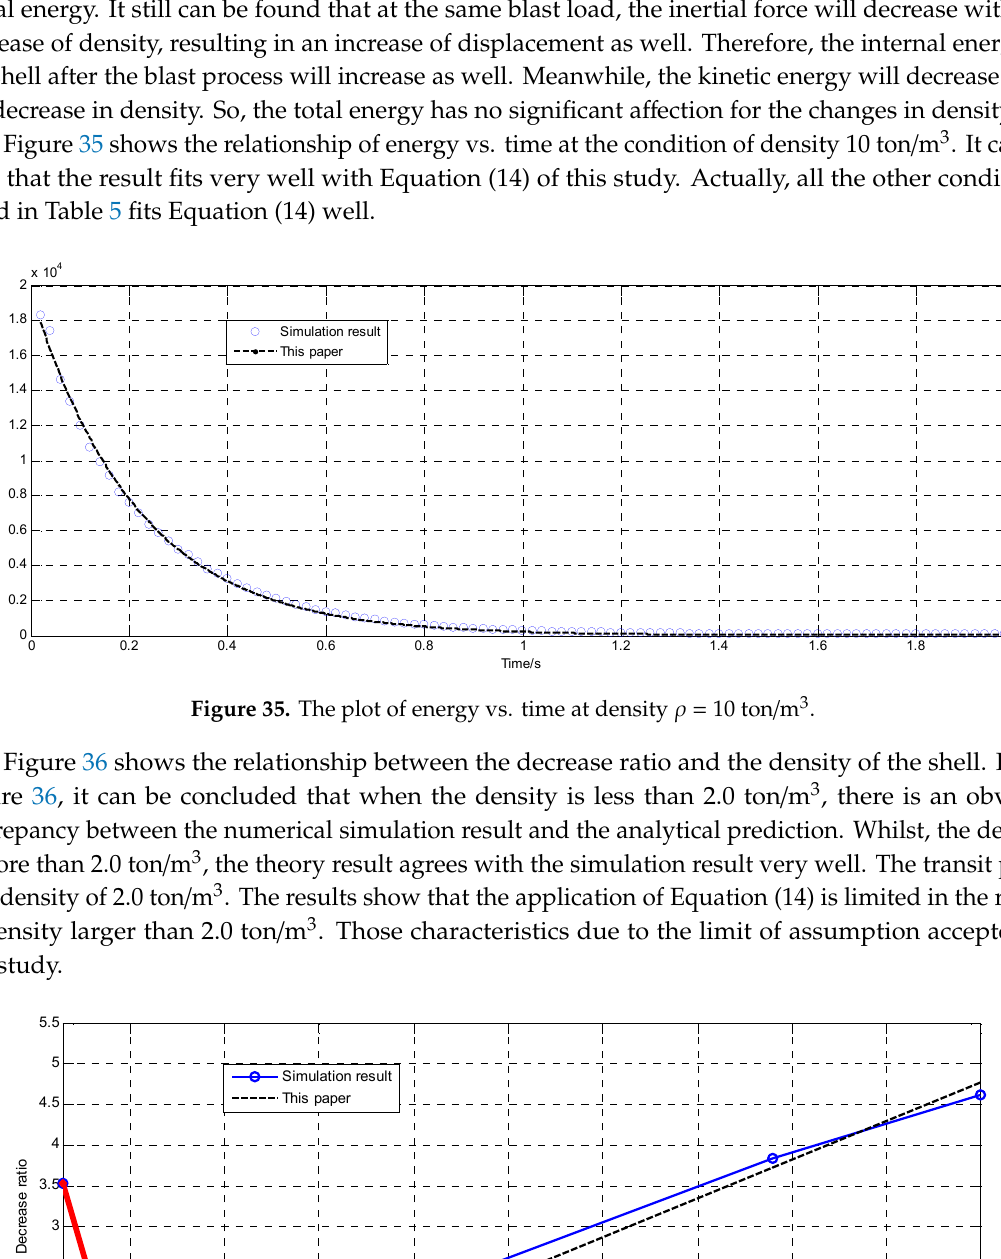
Figure 36. The plot of decrease ratio vs. density (t/m 3 ).